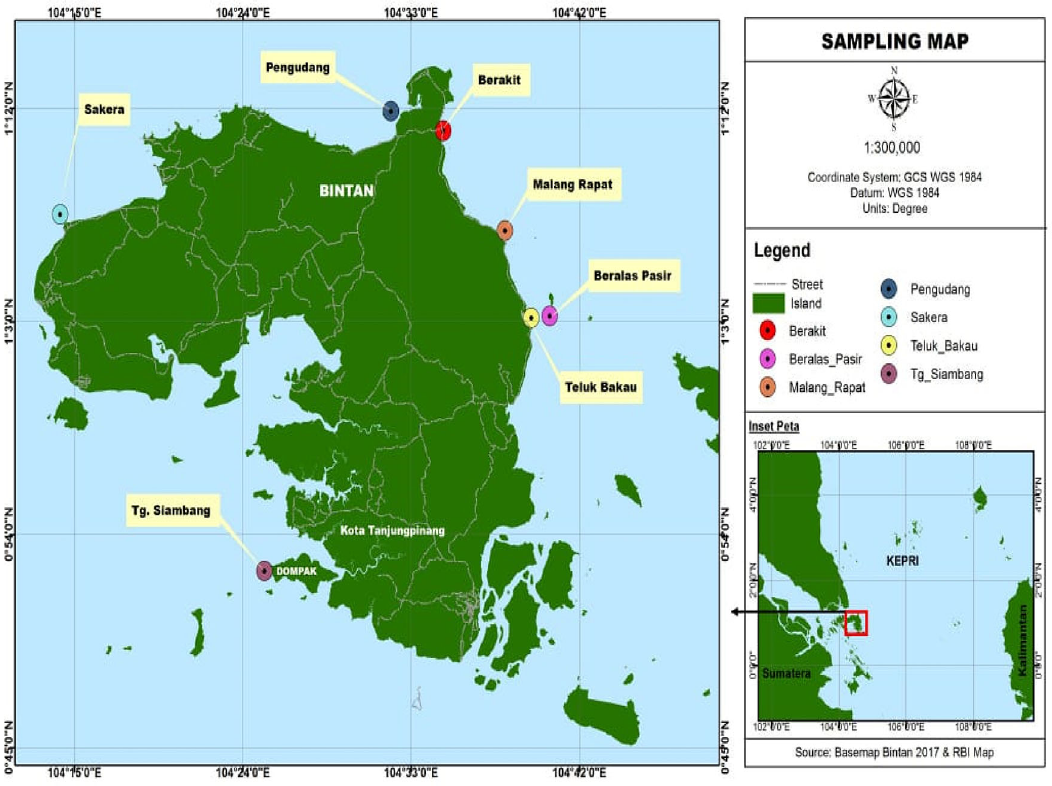
Figure1.Mapofresearchlocationsandfielddatacollection,Thisfigurehasbeenreproducedwithpermission from Apriadi et al . (2018).